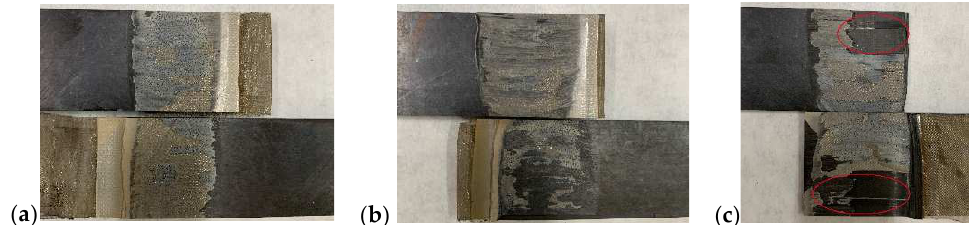
Figure 9. Photos of fracture surfaces of typical welded samples obtained with type B heating element at different power densities of ( a ) 58 kW/m 2 , ( b ) 66 kW/m 2 , ( c ) 74 kW/m 2 . Red circles indicate the positions of laminate damage.